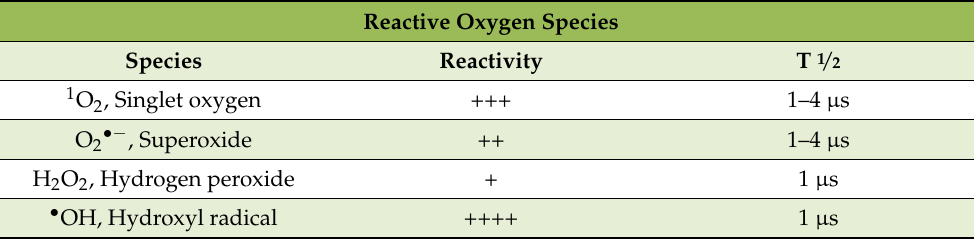
Table 1. Main reactive oxygen species, their reactivity and half-life